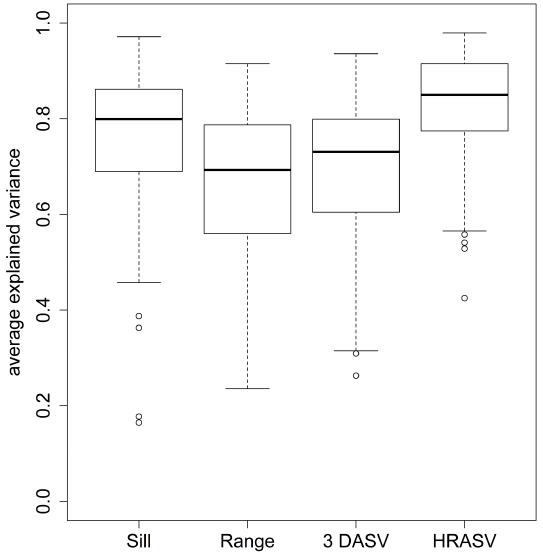
Figure 7. Box and whisker plot of the average variance in 5-year variogram characteristics explained by meteorological characteris- tics, calculated using the adjusted R 2 value and the variables in the model with the lowest AIC value (calculated using IT) for each